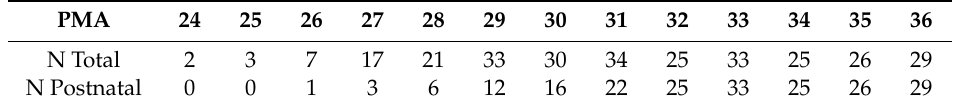
Table 2. Sample size for IGF-1 analyses per postmenstrual age.